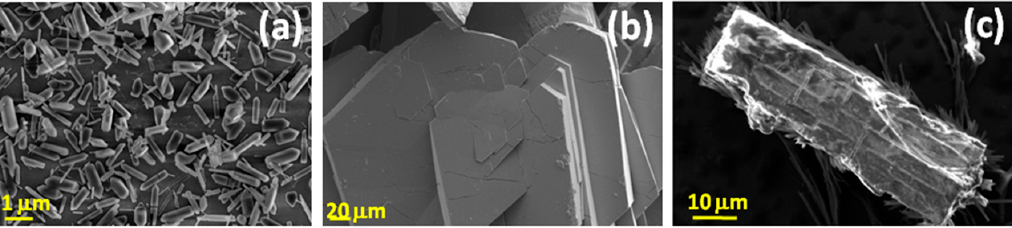
Figure 2. SEM micrographs of Eu-BTC ( a ) and Eu-PSA ( b ) crystalline materials. Eu-BTC “block” crystal after MSM exposition ( c ).